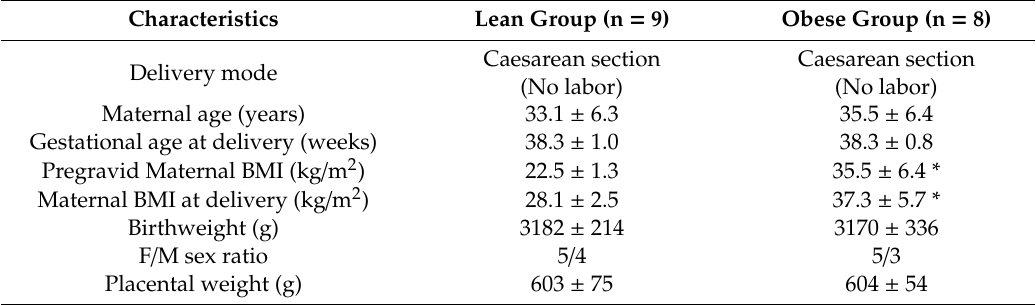
Table 1. Clinical and anthropometric characteristics in normal weight and obese pregnant women.